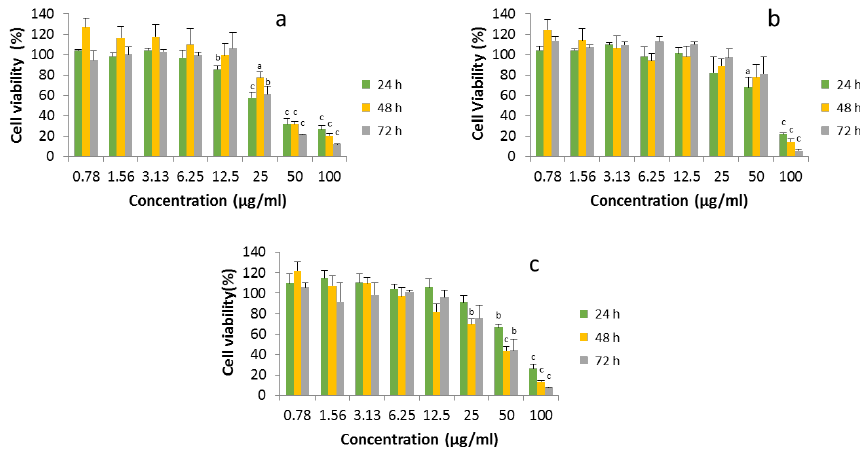
Figure 2. Cell viability of HaCaT cells exposed to different concentrations of ZnO ( a ) and ZnO 50 ( b ) and 100 nm ( c ), respectively, after 24, 48 and 72 h incubation. Mean values ± standard deviation of triplicates